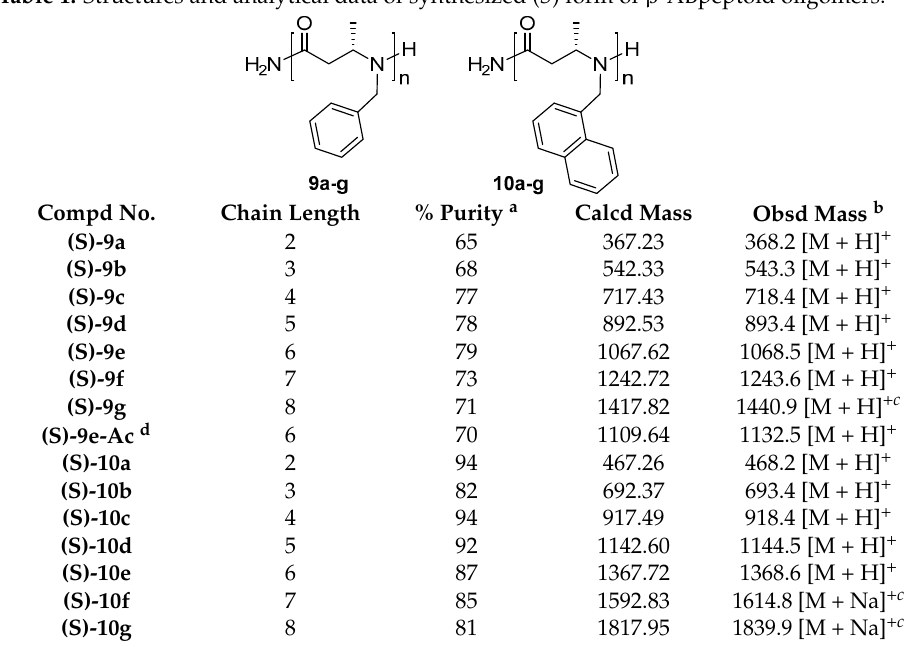
Table 1. Structures and analytical data of synthesized ( S ) form of β -ABpeptoid oligomers.